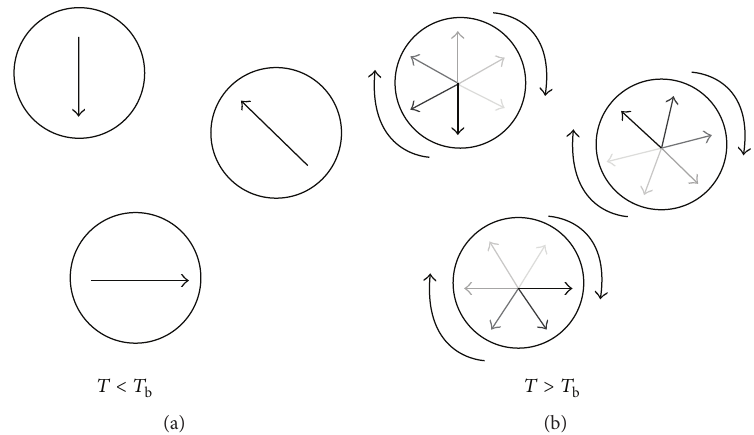
Figure 9: The details of superparamagnetic behavior as a function of blocking temperature and relaxation time. In state (a), temperature is below the blocking temperature and the anisotropy energy is dominated to the thermal energy; so, the moments are apparently fixed. In state (b), temperature is higher than blocking point and the thermal energy is larger than anisotropy one; thereby, the superparamagnetic structure is formed